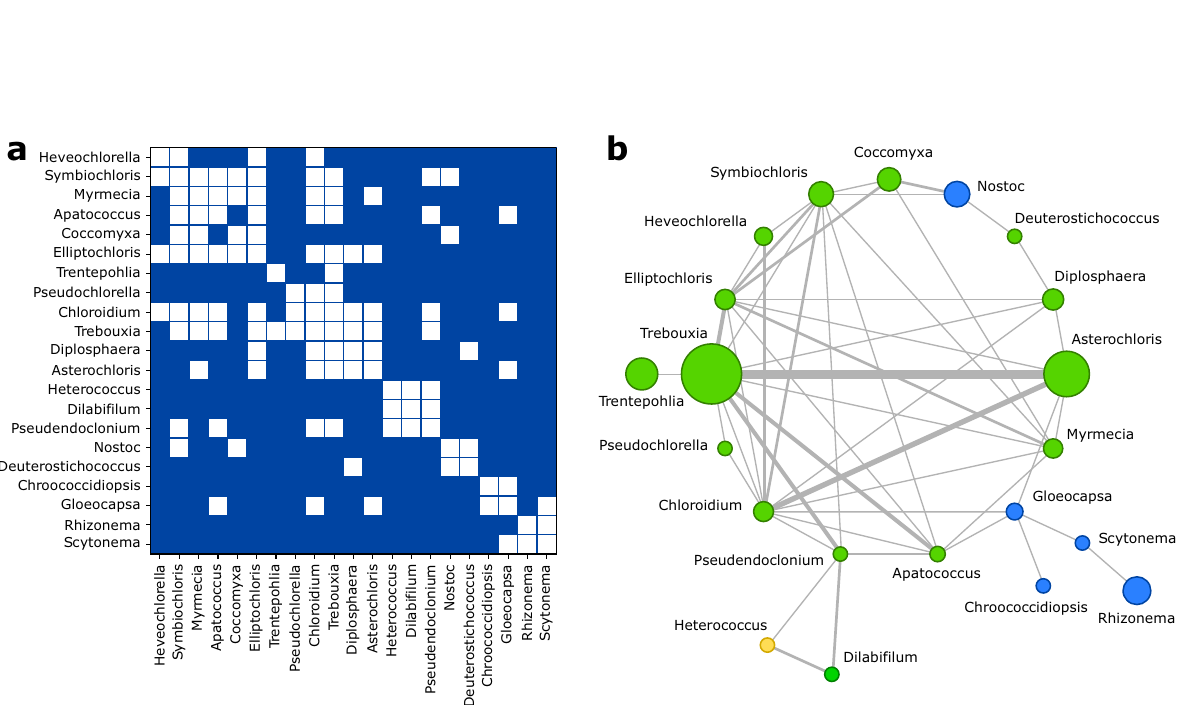
Heveochlorella Symbiochloris